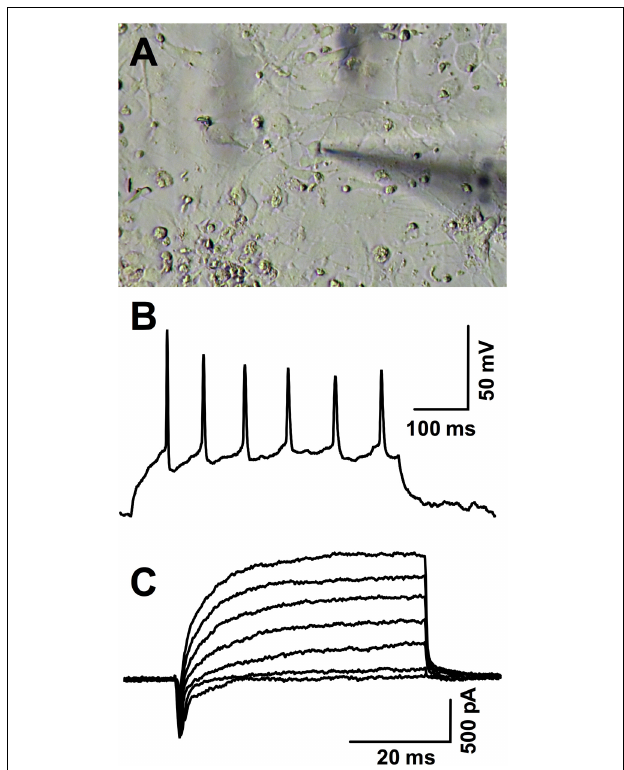
FIGURE 4 | Patch-clamp recordings in hiPSC-derived neurons. (A) Photomicrography illustrating the patched neuron whose action potentials are shown in (B) . (B) Action potentials fired during a 30 pA positive current injection (baseline: –70 mV) and (C) inward and outward voltage-gated currents evoked in the same representative cell in response to incrementing depolarizations from –90 mV to –40, –30, –20, –10, 0, 10, and 20